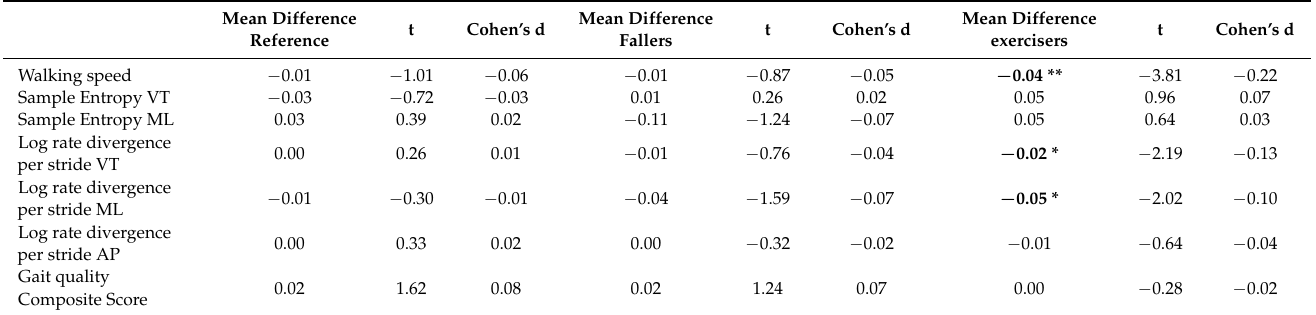
Table 3. Mean change in gait quality characteristics (corrected for walking speed) between baseline and follow-up in the reference group, fallers, and exercisers and their effect sizes.